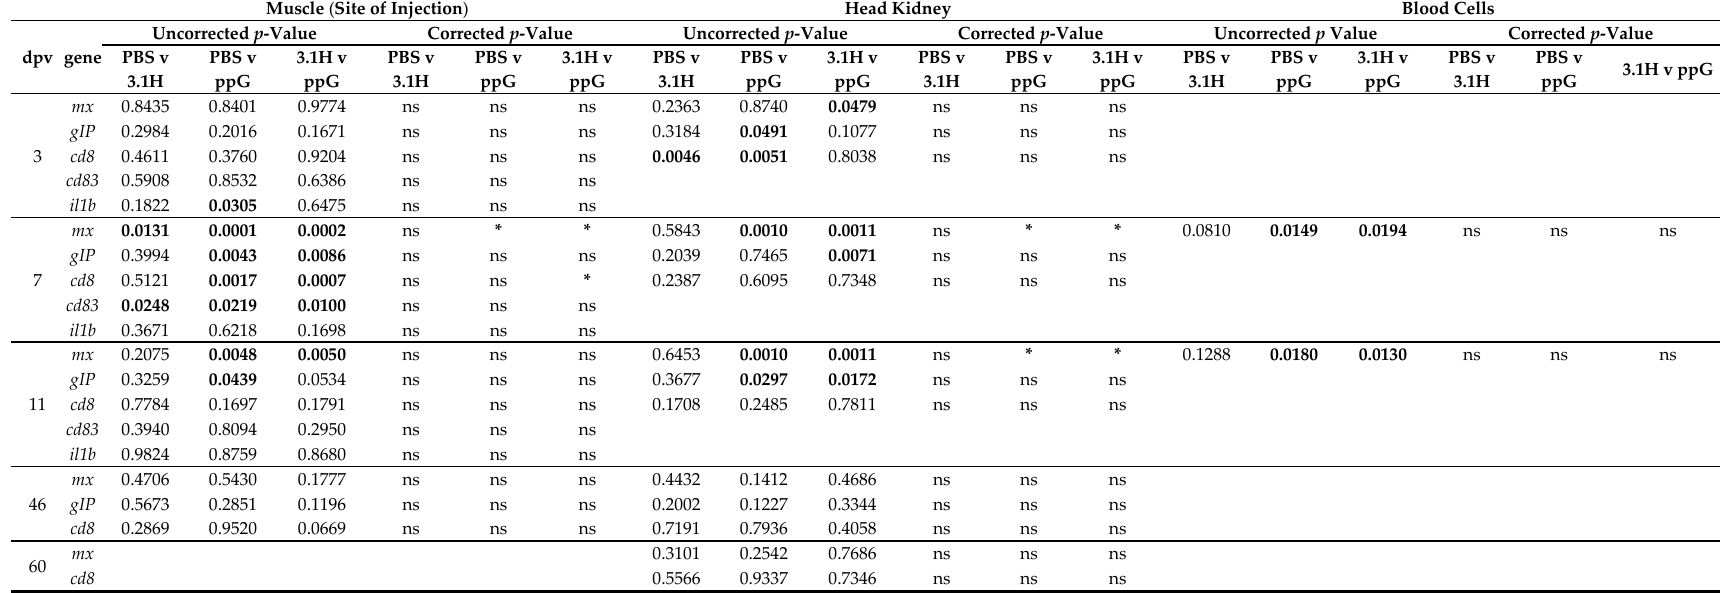
Table 2. Statistical analysis of the qPCR gene expression data from the Exp 1. Values in bold are p -values indicating significant differences in expression between indicated groups before adjustment for multiple comparisons, and * indicates adjusted p -value giving significance ( p < 0.00119). B–H: Benjamini–Hochberg method (Benjamini and Hochberg, 1995) for adjusting p -values to accommodate type 1 errors following multiple t-tests, using a false discovery rate (FDR) of 0.05. dpv: days post-vaccination, PBS: PBS injected control fish, 3.1H: empty vector (pcDNA3.1-Hyg), ppG: DNA vaccine (pcDNA3.1-Hyg vector containing SPDv subtype 1 struc- tural protein